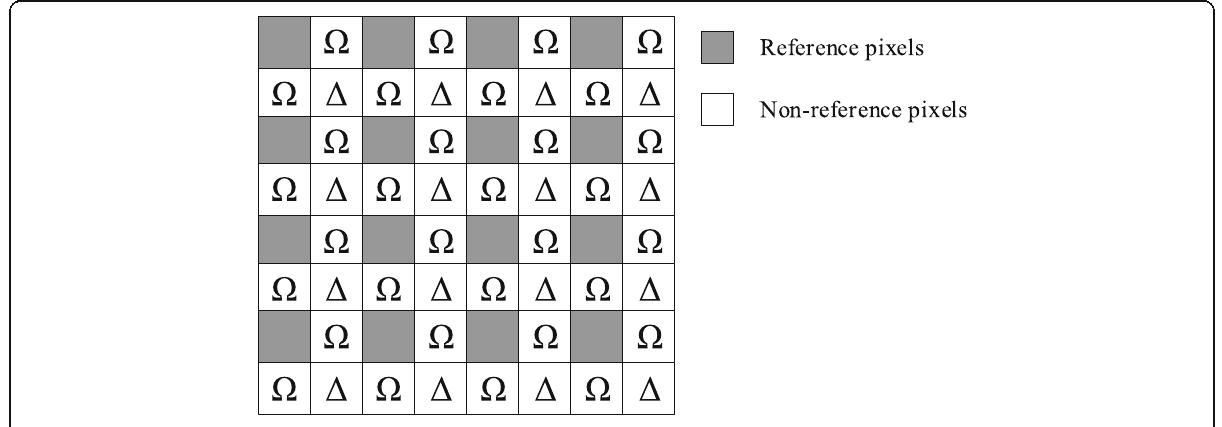
Fig. 2 Division of pixels for